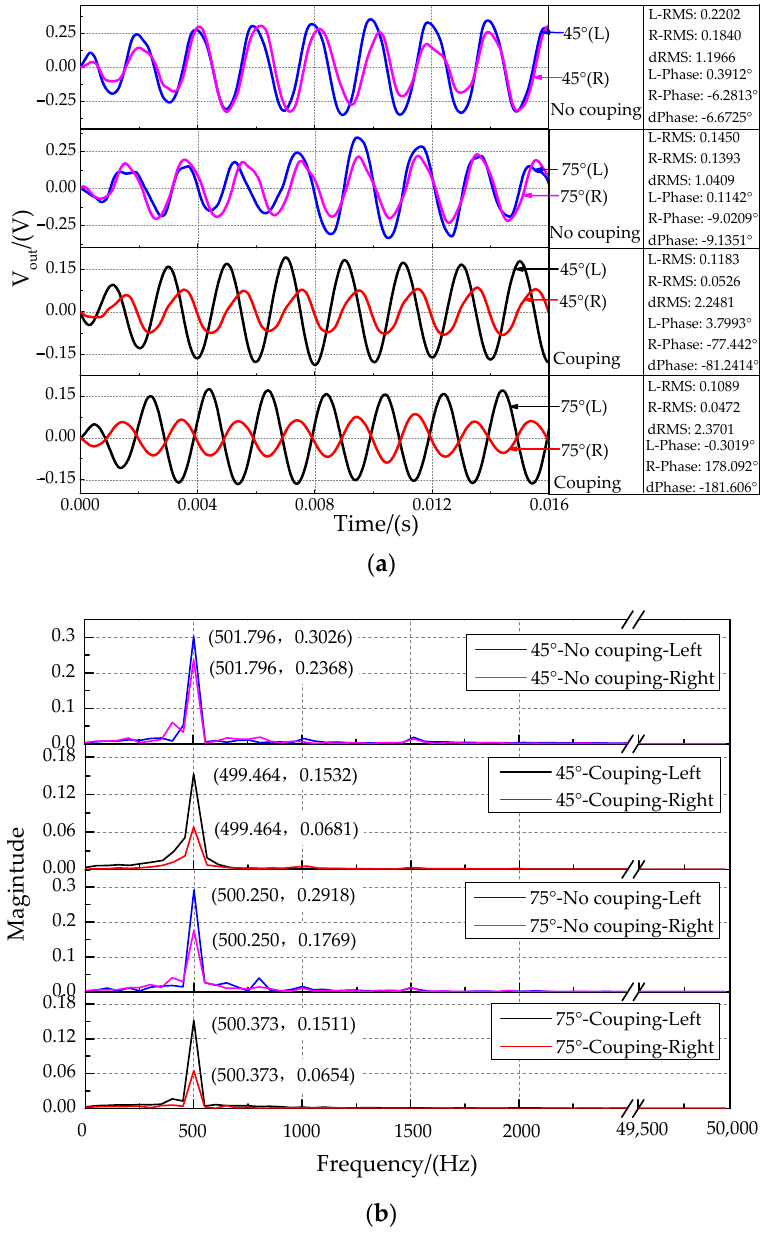
Figure 17. Characteristics at the sound source incident angle of 45 ◦ and 75 ◦ . ( a ) The time-domain characteristics. ( b ) The frequency-domain characteristics.